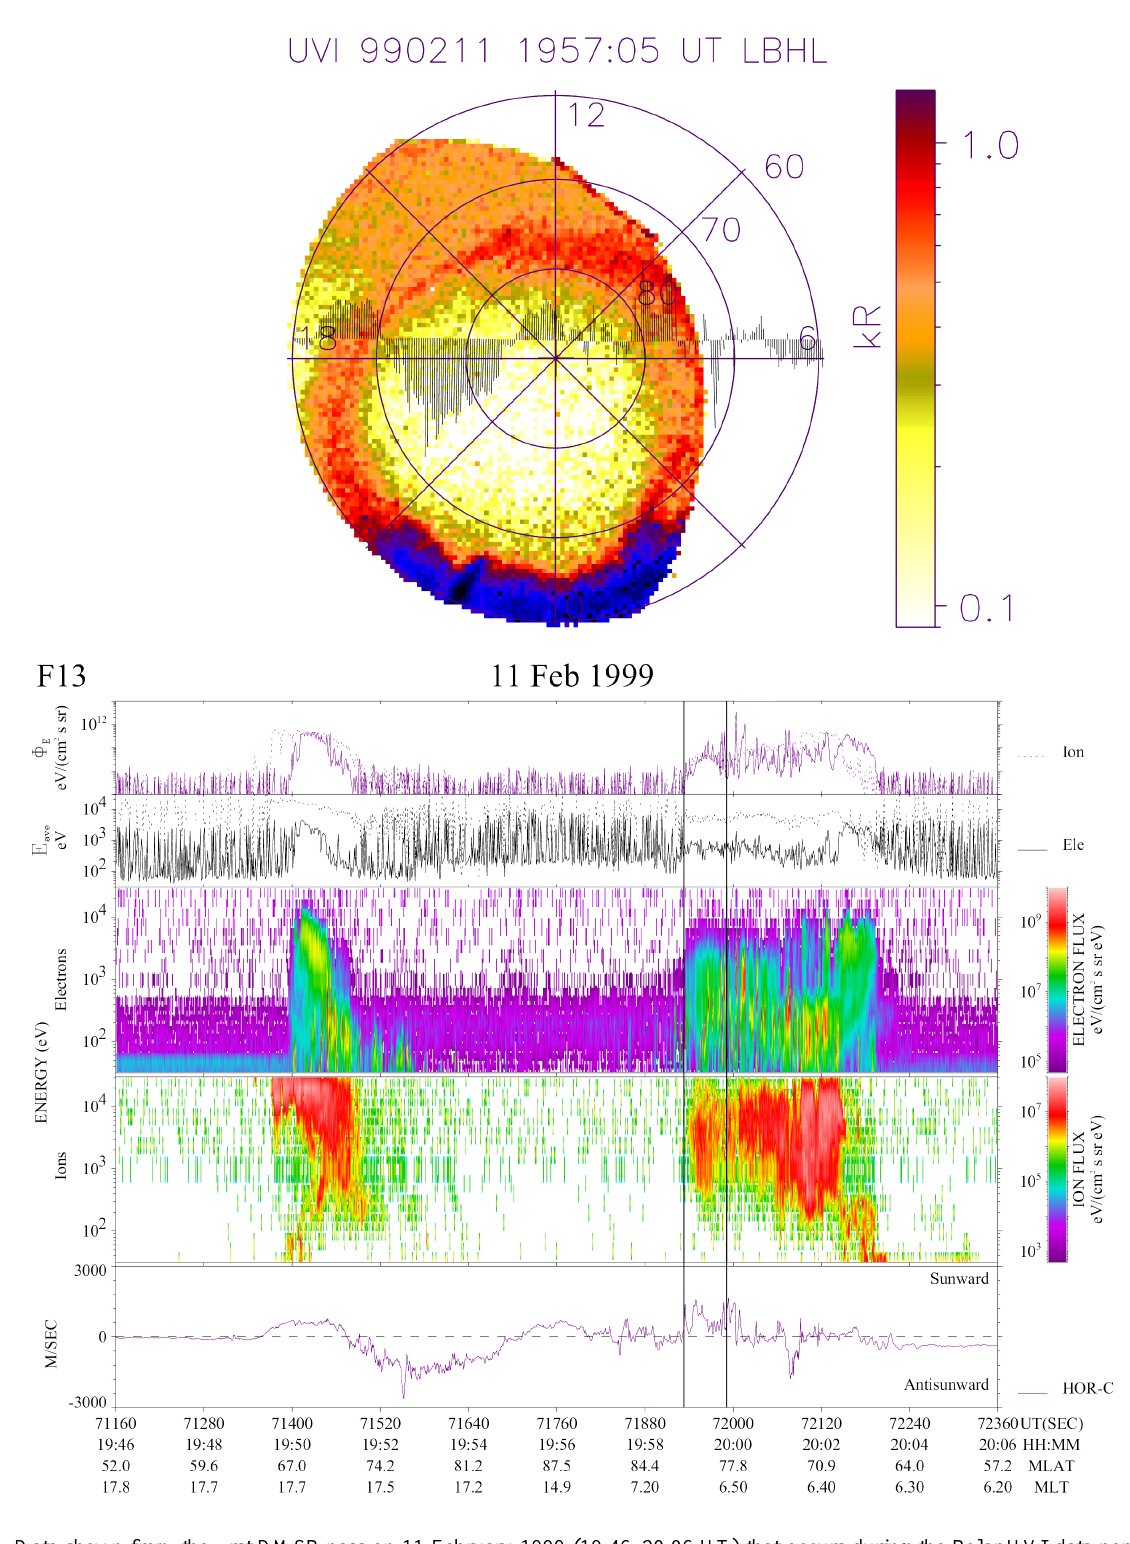
Fig. 7. Data shown from the first DMSP pass on 11 February 1999 (19:46–20:06 UT) that occurs during the Polar UVI data period. At the top are the F13 horizontal plasma flows, perpendicular to the satellite track plotted over a UV image taken at the time F13 is at highest magnetic latitudes. The F13 spectrogram (lower panel) includes, from top to bottom, (1) electron and ion integral energy flux, (2) electron and ion average energy, (3) precipitating electron spectrogram, (4) precipitating ion spectrogram, and (5) cross-track horizontal plasma drift. See text for